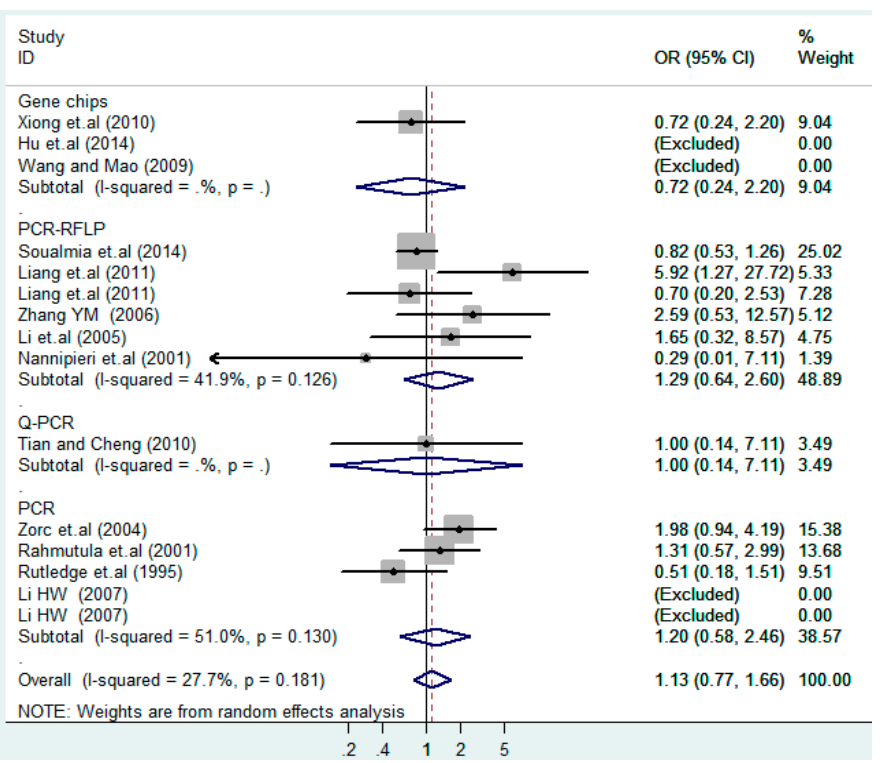
Figure 22. Subgroups of genotyping methods of T2238C dominant model (CC + TC) vs. TT.